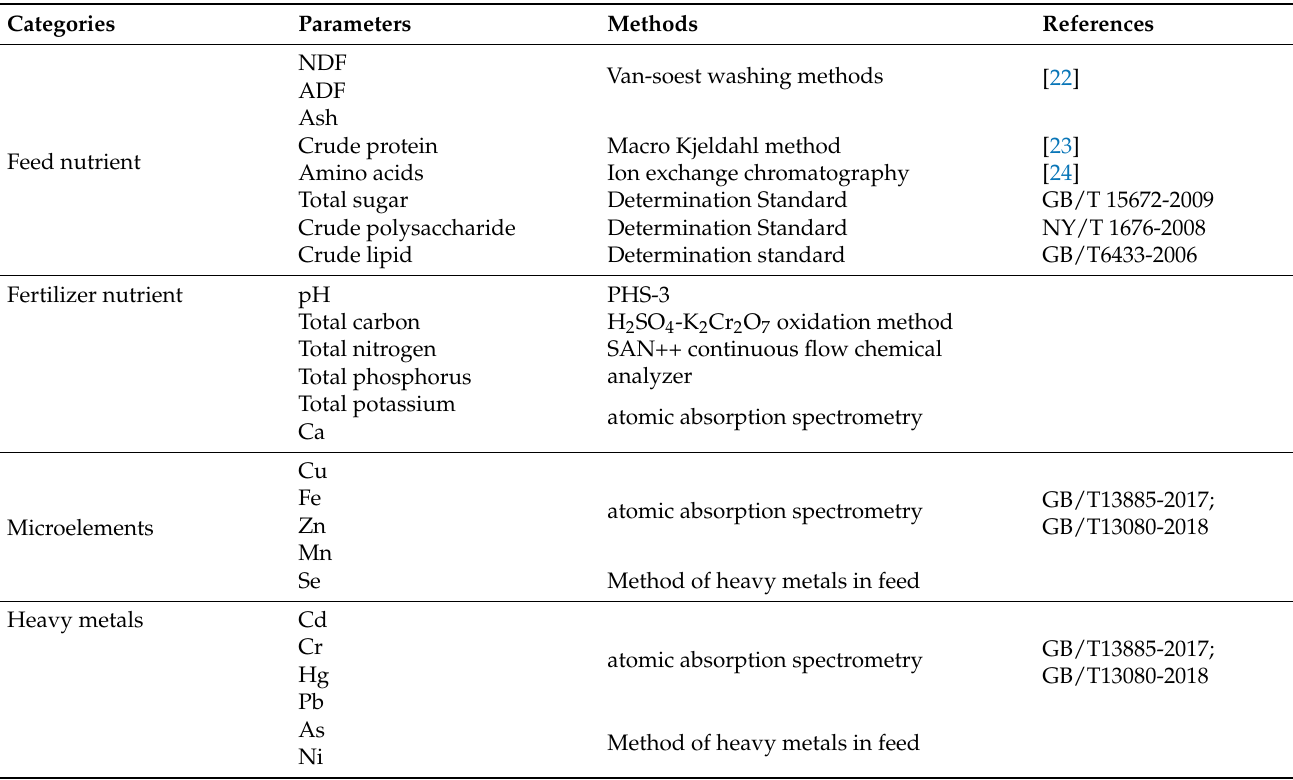
Table 1. Effect of cultivated different variety of mushroom on microelements of